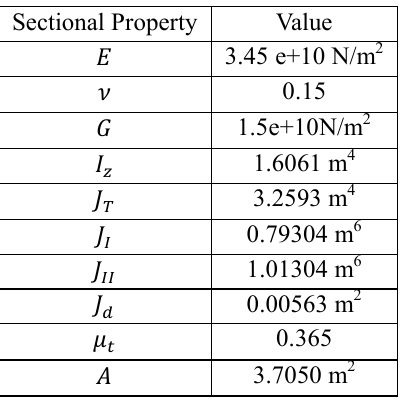
Cyclic frequencies for first ten modes.